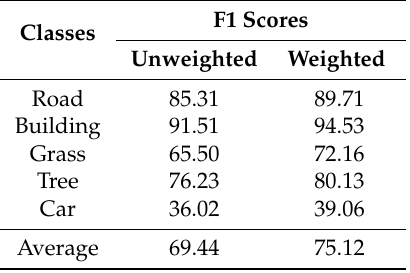
Table 3. F1 score of each class and average calculated from the original (unweighted) and proposed (weighted) confusion